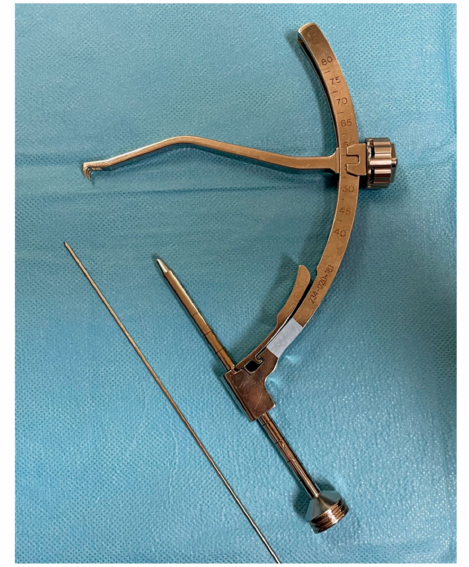
Figure 1. Sharp-ended tibial guide from ACL reconstruction set used to reduce and to stabilize tibial eminence with K-wire by retrograde drilling. A sharp tip is inserted through the anteromedial arthroscopic portal into the joint on top of the fragment to reduce and hold the fracture in the desired position. After establishing the desired alignment, a fracture is fixed by retrograde drilling 1.2 mm K-wire through the assembled